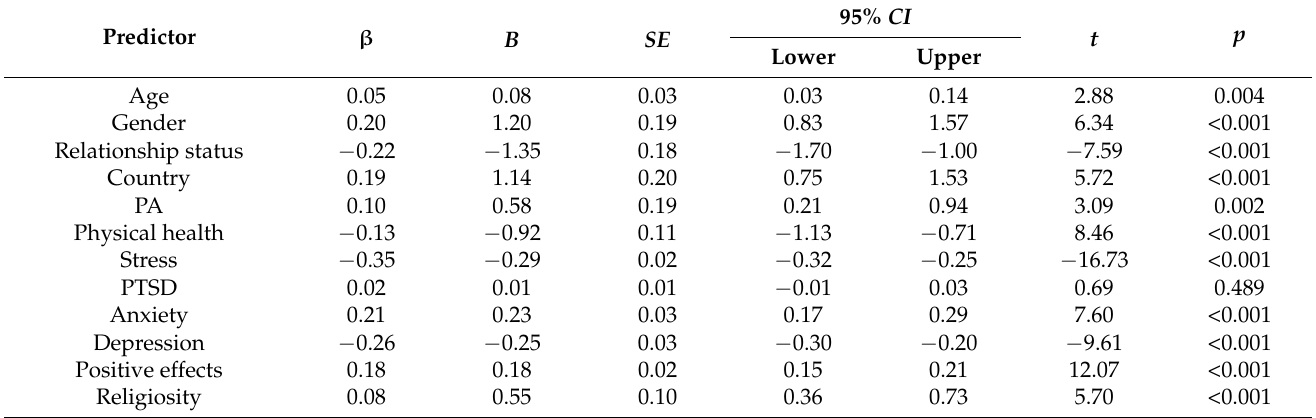
Table 6. Multiple linear regression for life